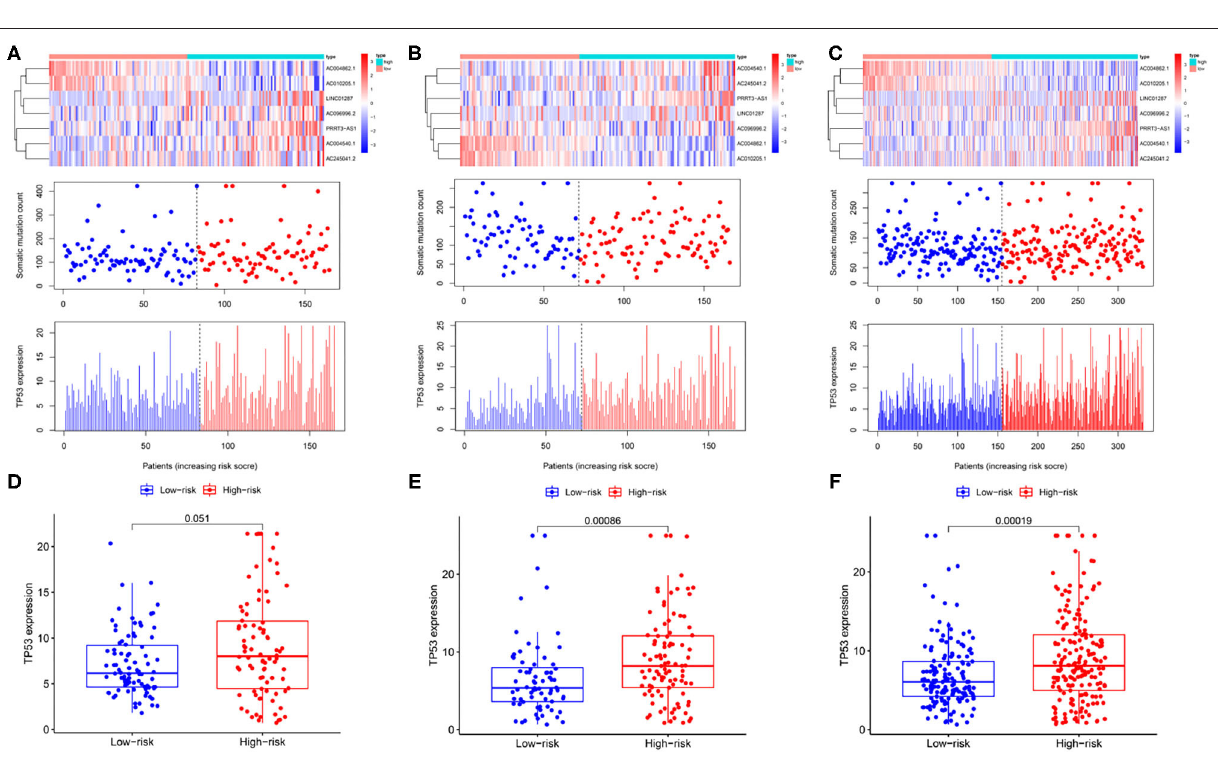
FIGURE 4 | Identification of the genomic instability-related lncRNA signature for outcome prediction. Heatmap of LncRNAs and the distribution of somatic mutation and TP53 expression with increasing risk score in the training group (A,D) , in the testing group (B,E) , and the entire group (C,F)